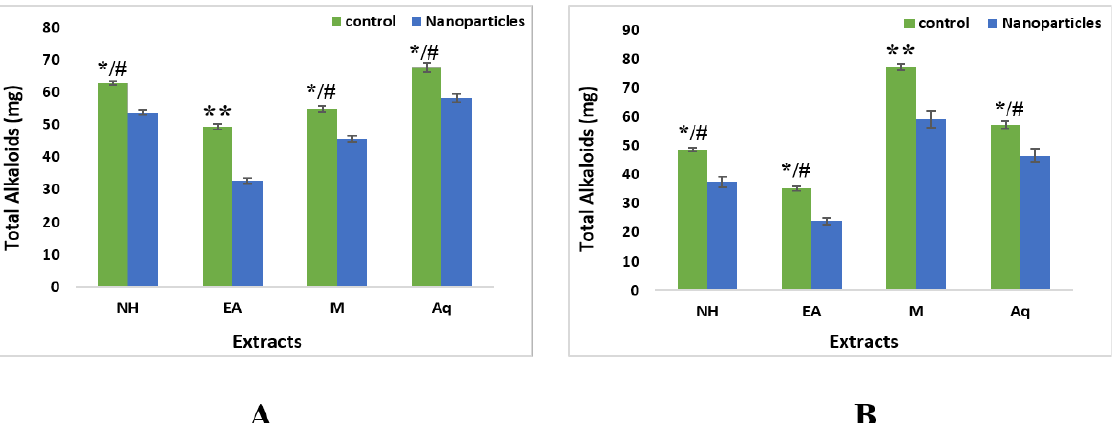
Figure 10. Total alkaloid contents of nanoparticles and control extracts of W. somnifera ( A ) From Leaves ( B ) From Roots. Data are expressed as the mean ± SD. */# p < 0.05, ** p < 0.01.